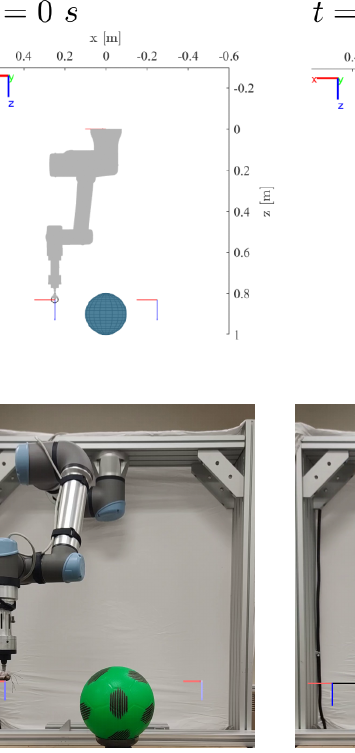
Figure 7. Test case 2: avoidance of a fixed obstacle while the robot moves along a linear path, Mode I. Simulated ( top ) and real ( bottom ) motion of the